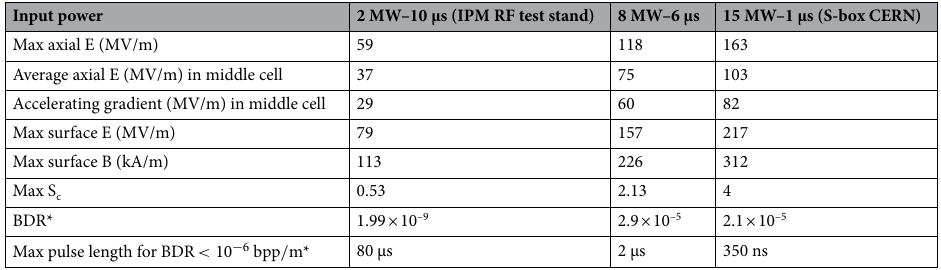
Table 2. The investigation of using different RF power for testing the designed cavity based on simulation results. *By rescaling CLIC experimental data ( 5 W / µ m